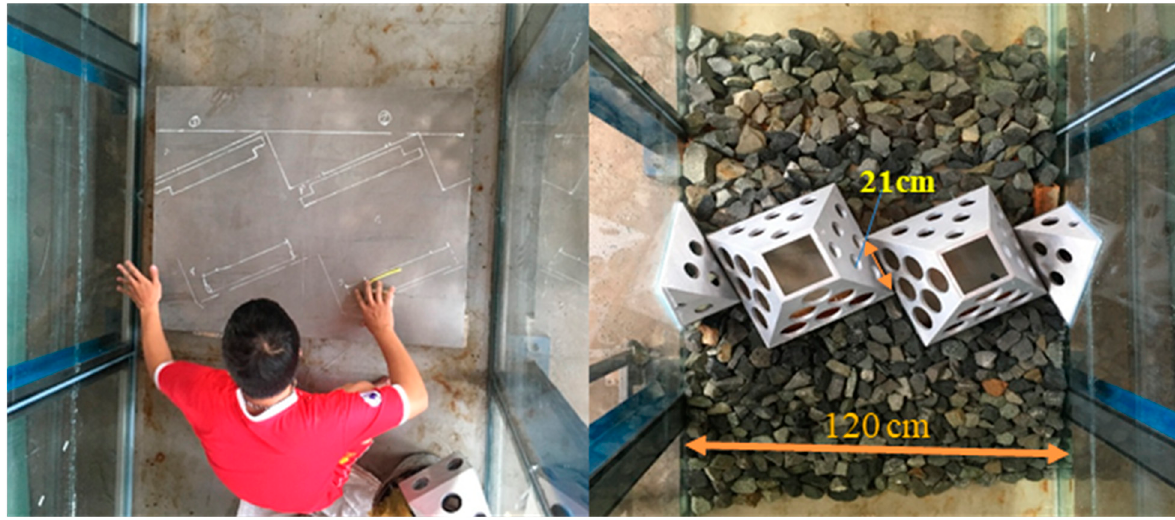
Figure 8. Setting up the model block in the wave flume.